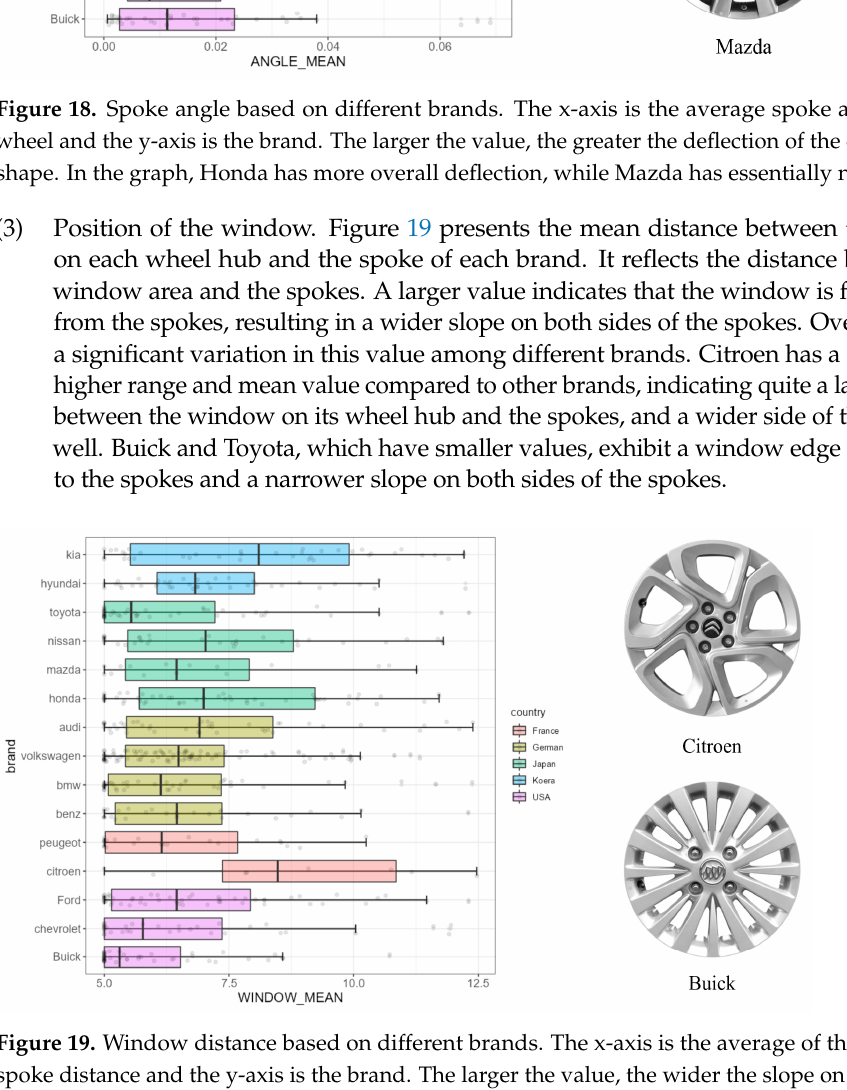
Figure 19. Window distance based on di ff erent brands. The x-axis is the average of the window-to- spoke distance and the y-axis is the brand. The larger the value, the wider the slope on either side of the spoke. In the graph, Citroen has a wider slope, while Buick has a narrower slope.